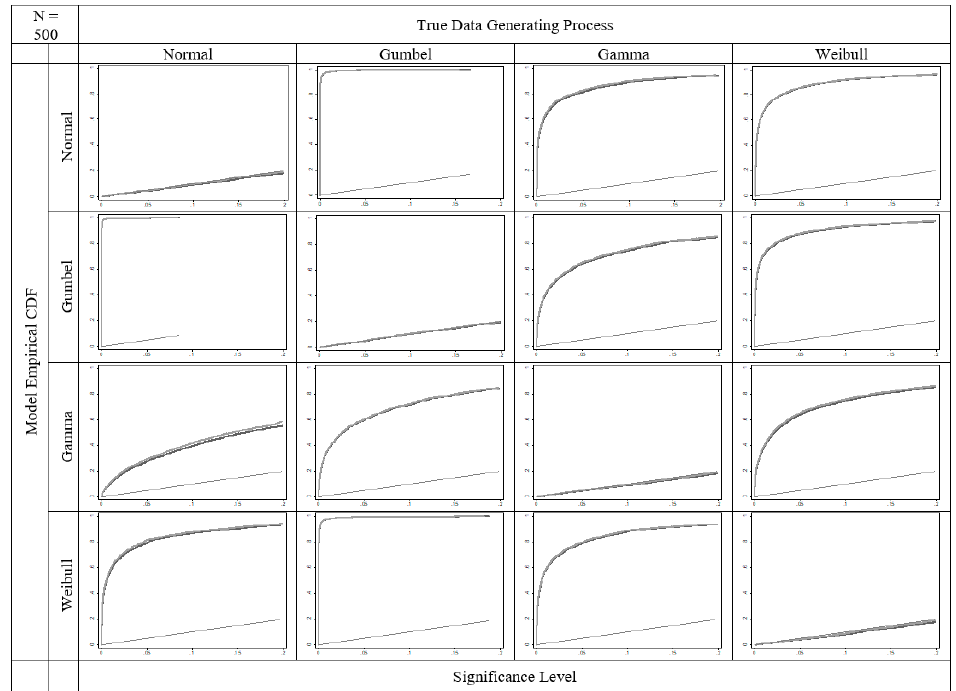
Table 2. Monte Carlo Simulation: Empirical CDFs of Experiments on Distribution Specifications